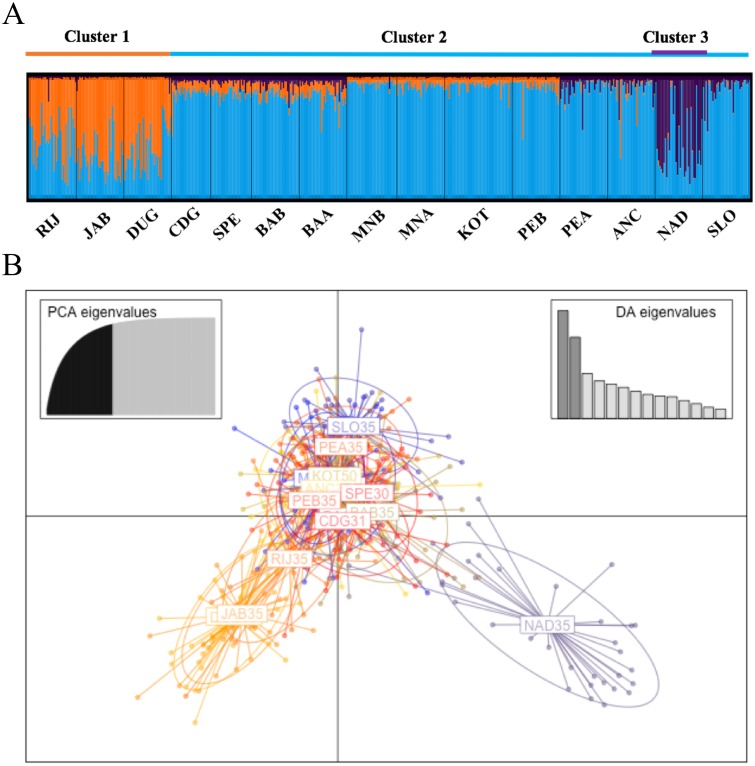
Graphical outcomes of STRUCTURE simulations for K = 3 using all loci and the LocPrior function (barplots represent the individual q values) (Fig 2A).Graphical outcome of DAPC plot (Fig 2B).